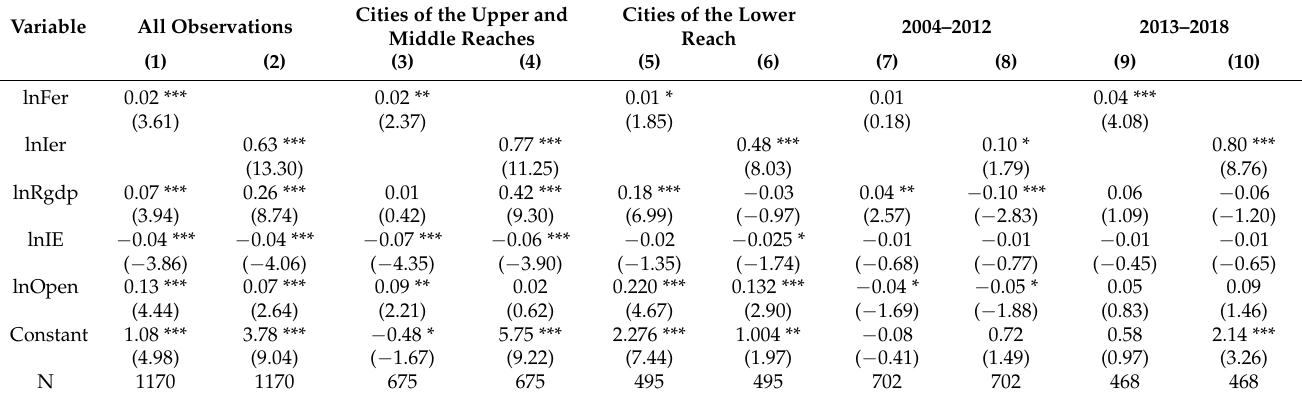
Table 3. Benchmark regression results of environmental regulation on industrial structure